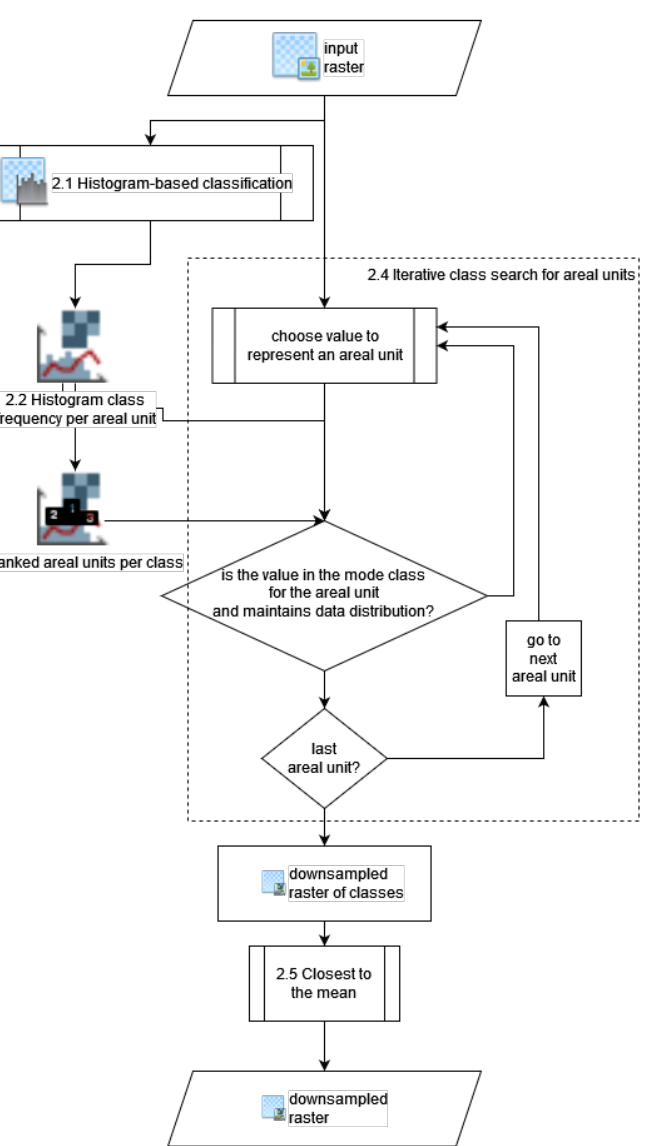
Figure 1. Overview of the novel downsampling method. The steps are further detailed in the text. A more detailed version of this chart is presented in Appendix A flowchart, split into Figures A1 and